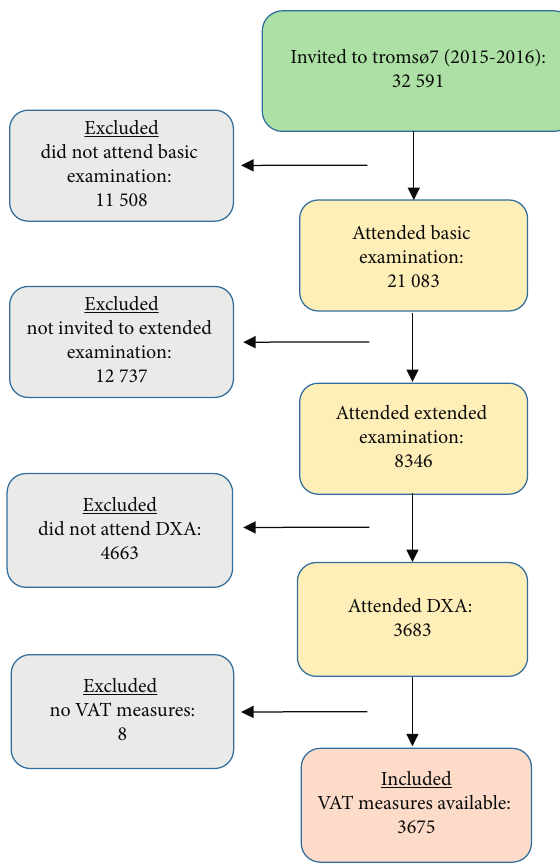
Figure 1: Inclusion of